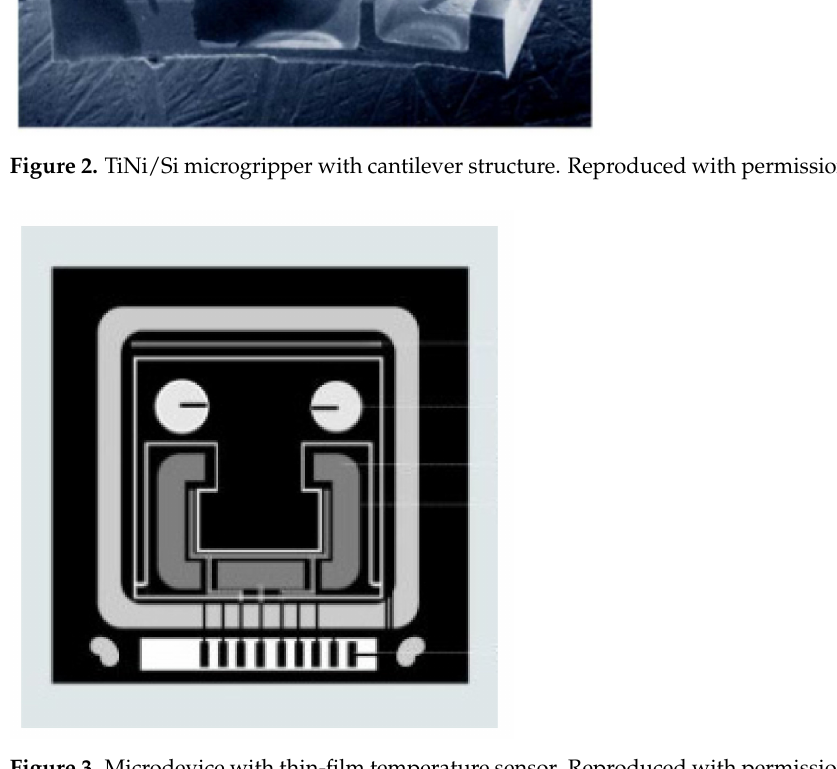
Figure 3. Microdevice with thin-film temperature sensor. Reproduced with permission from Ref.